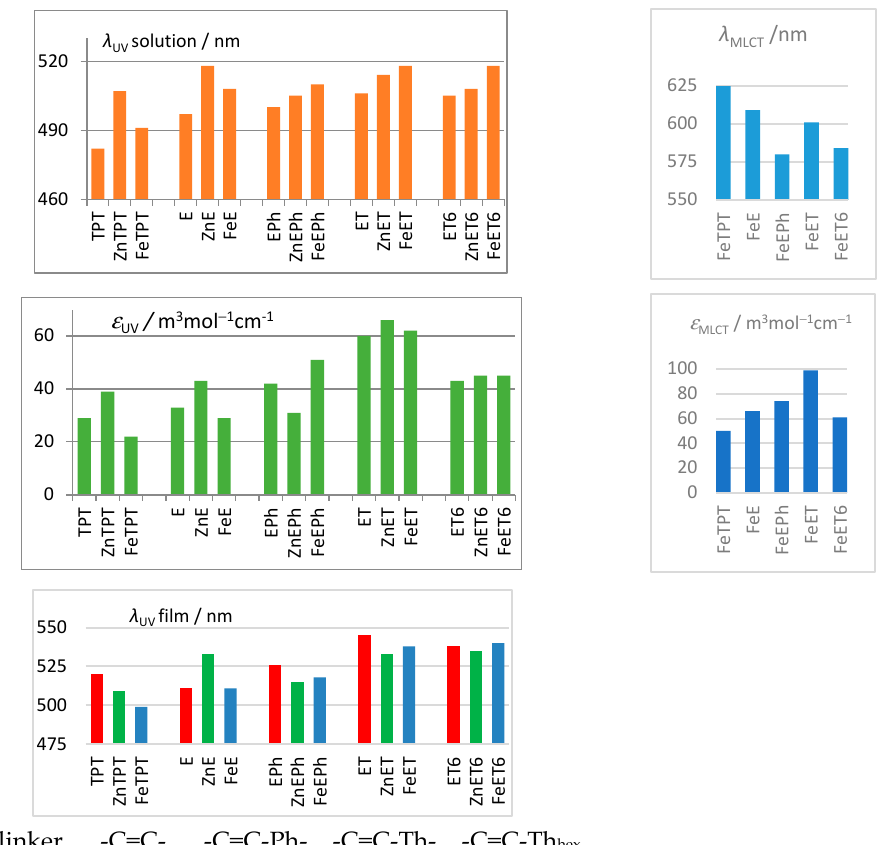
Figure 2. Effect of the linker structure on the UV/vis characteristics of unimers and